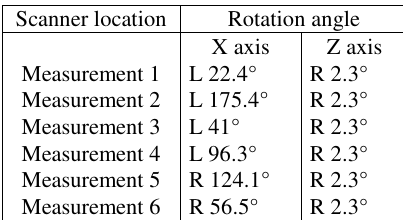
Figure 5. Rotation of z axis (a) and x axis (b) of the point cloud on the scanner origin.